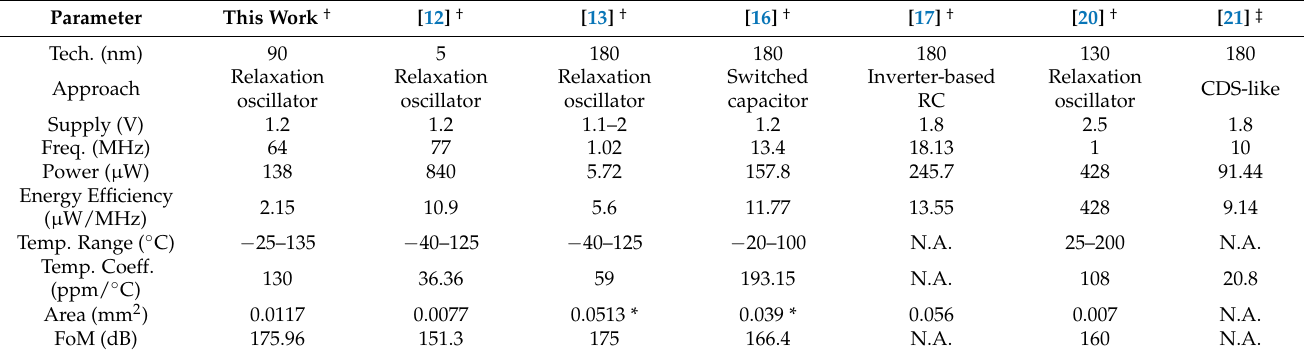
Table 1. State-of-the-art performance summary and